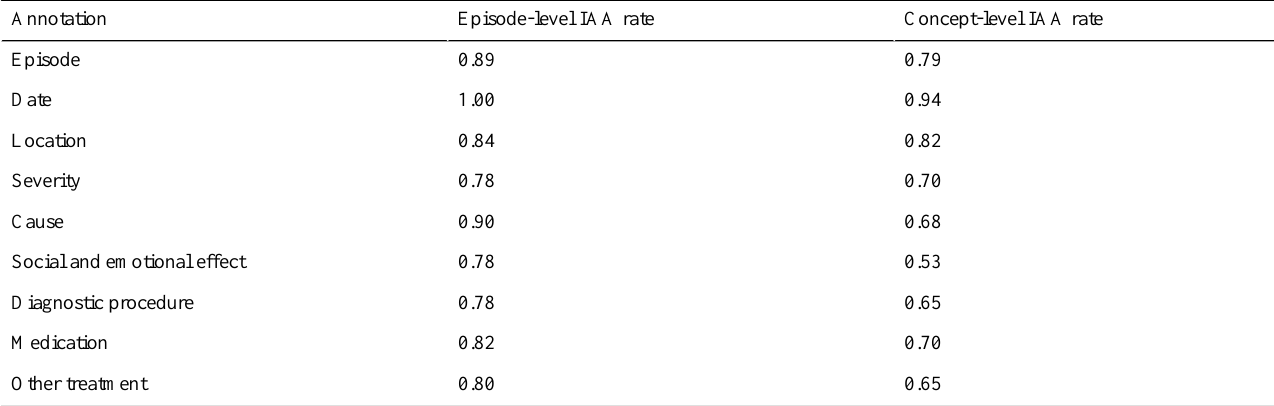
Table 3. Interannotator agreement (IAA) rates computed using the F1